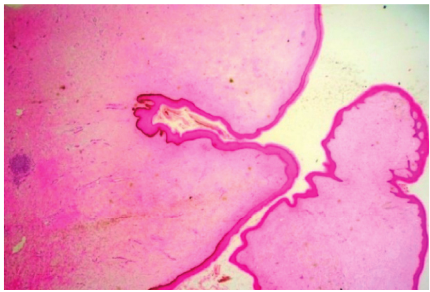
Figure 3: A hematoxylin and eosin stain of the fibroepithelial polyp showing a verrucous surface covered by acanthotic stratified squamous epithelium with hyperkeratosis. The stroma is hypo- cellular and collagenous.